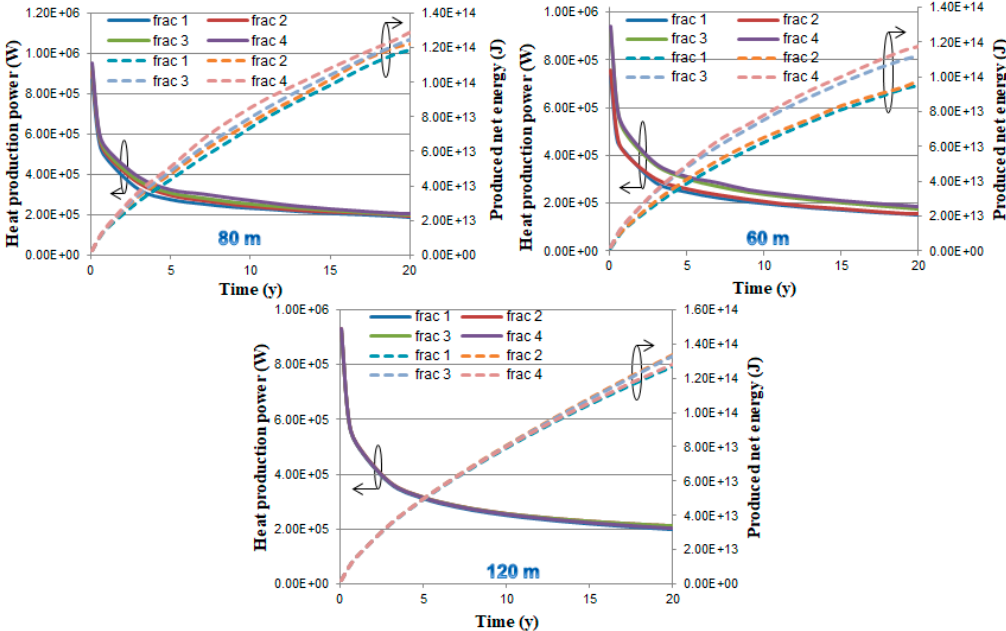
Figure 10 . Comparative results of produced net heat and heat production power within 20 years with 60, 80, and 120 m fracture spacing.